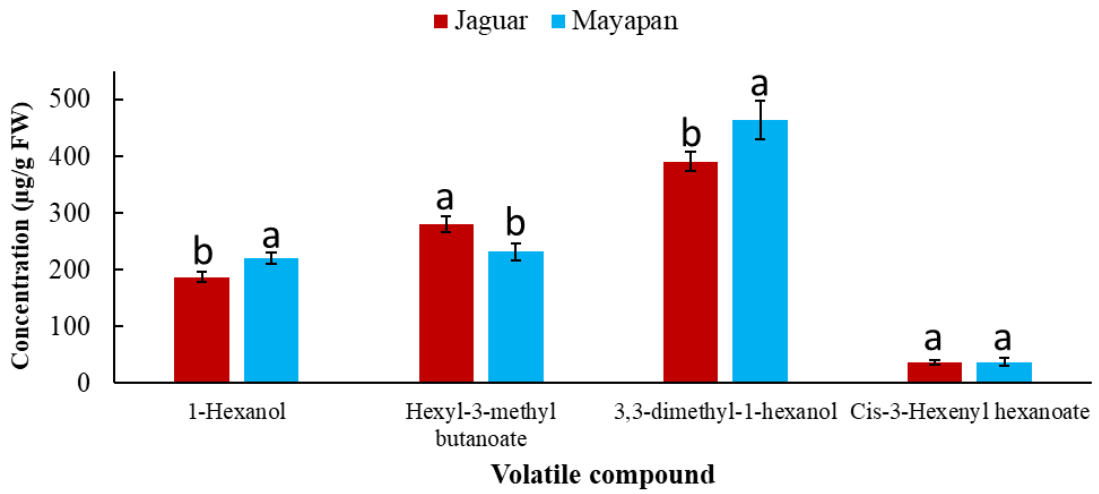
Figure 2. Bar plots of: 1-hexanol, hexyl-3-methyl butanoate, 3,3-dimethyl-1-hexanol, and cis-3- hexenyl hexanoate. Error bars represent the standard uncertainty ( p ≤ 0.05). Different letters in the same volatile compound indicate statistically significant differences using minimum significant differences (MSD) test at p ≤ 0.05. Results presented in the figure are the average of both the three evaluated soils and the two degrees of ripeness of the Habanero pepper. The concentration of volatile compounds is expressed on a fresh weight (FW) basis.